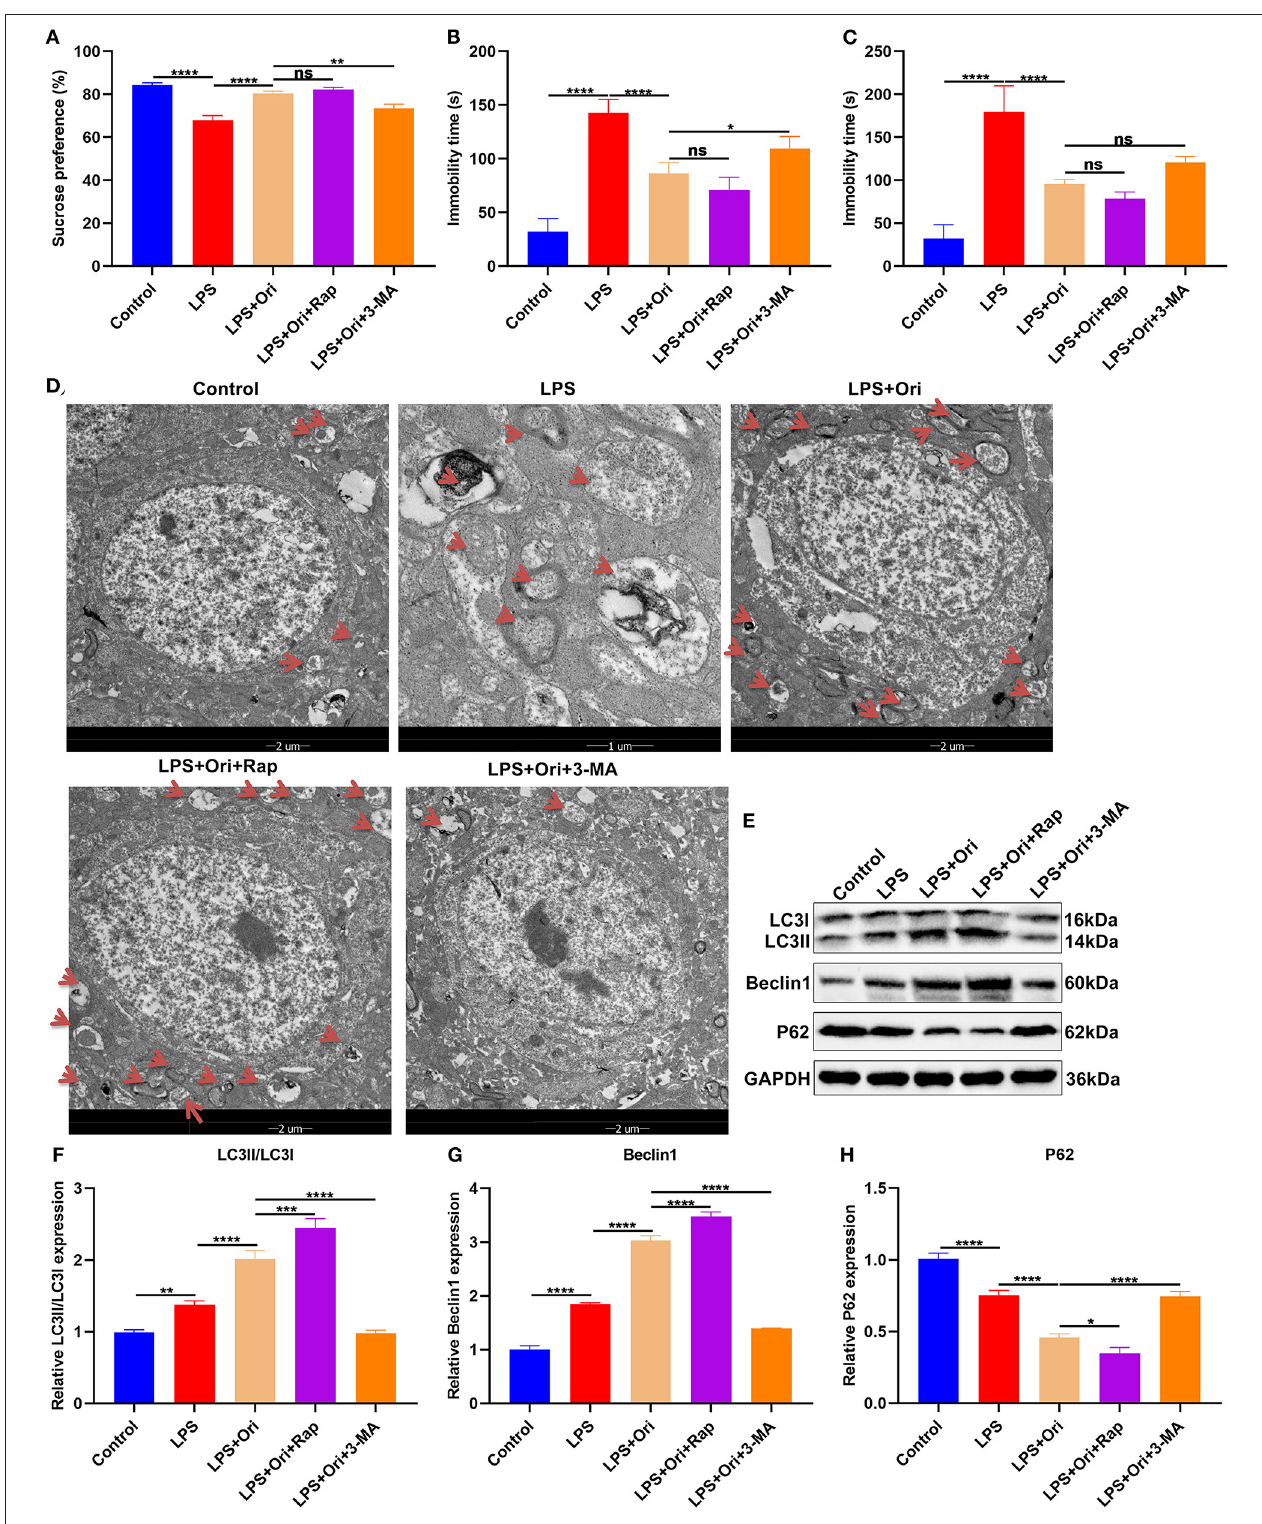
FIGURE 1 | Effects of Ori, autophagy agonist Rap and inhibitor 3-MA on depressive-like behaviors in LPS-induced depression mouse models. (A–C) Sucrose preference, immobility time of FST and TST in each group. (D) TEM showing the size and number of autophagosomes in the hippocampus in each group. Red arrows, autophagosomes. Magnification, 5000 × (1 µ m) and 1700 × (2 µ m). (E–H) Western blotting for detecting LC3II/I, Beclin1 as well as P62 levels in the hippocampus of each group. N = 6 each group. P values were calculated with ANOVA with Turkey’s post-hoc test. Ns, not significant; * p < 0.05; ** p < 0.01; *** p < 0.001; **** p <